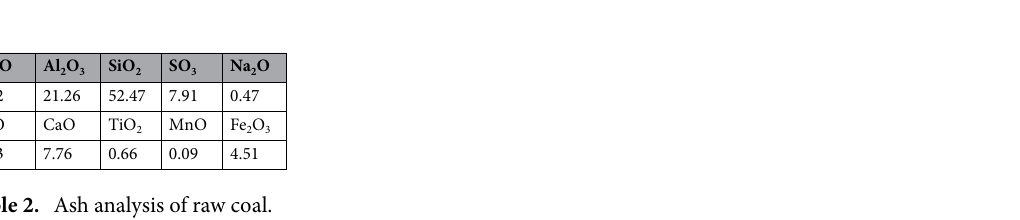
Table 2. Ash analysis of raw